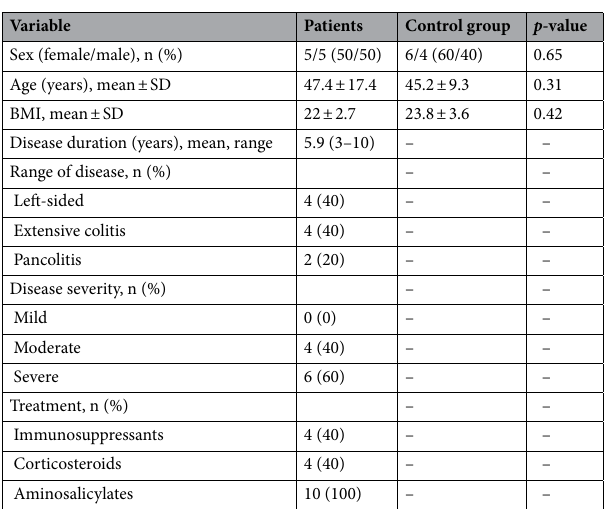
Table 1. Baseline characteristics of UC patients and control group. p -value calculated using t